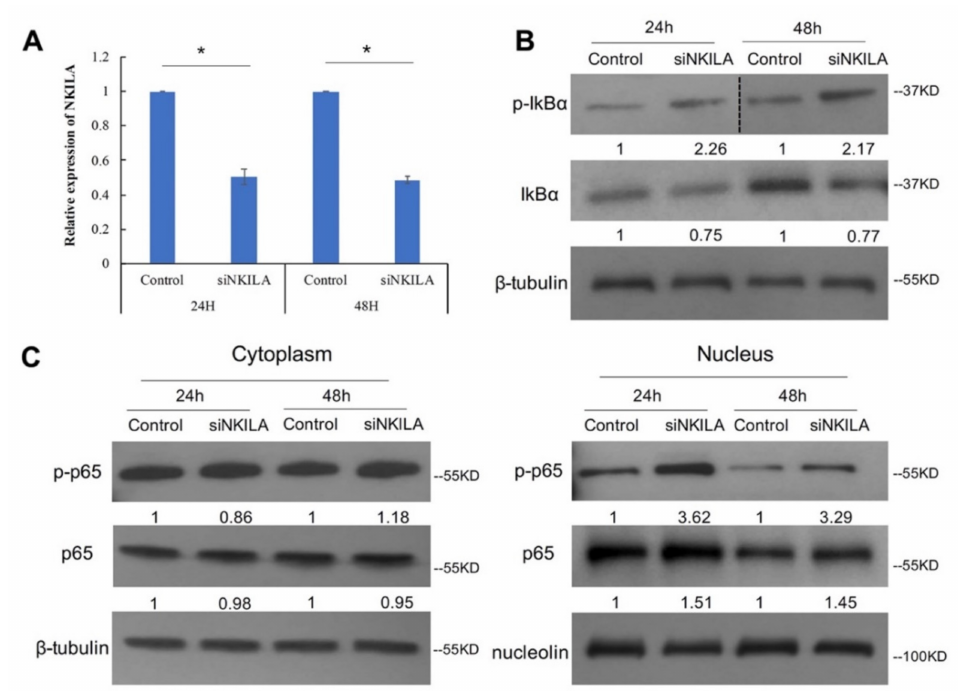
Figure 4. NKILA knockdown leads to more I κ B α phosphorylation and more p65 translocated into